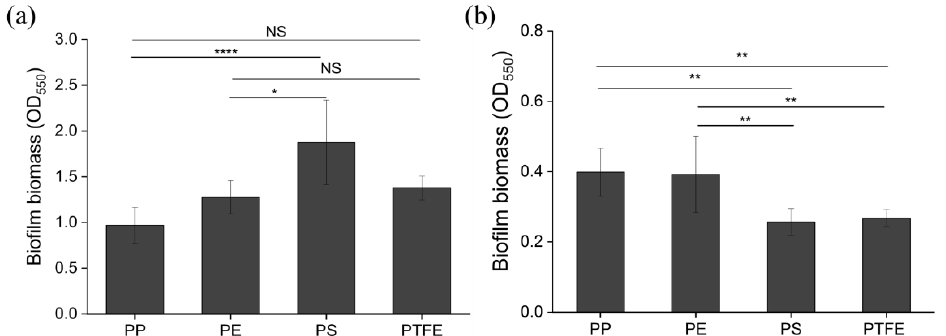
Figure 2. ( a ) Biofilm formation on the well surface. Error bars were defined as standard deviations (n = 8, biological replicates). One-way ANOVA was performed and the Tukey post hoc test was conducted to compare the number of biofilms where significant differences are indicated as fol- lows: NS, not significant p > 0.05, * p < 0.05, and **** p < 0.0001. ( b ) Biofilm formation on the micro-